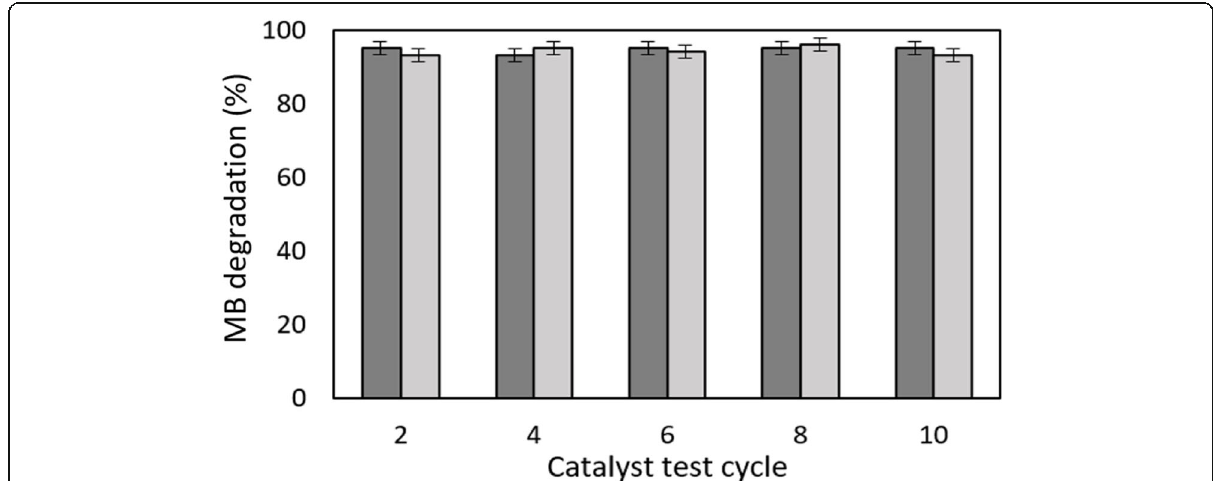
Fig. 10 MB degradation reached after 150 min of reaction under optimal conditions using Nb 2 O 5 /Al 2 O 3 /Al catalyst. Ref: MB solution (distilled water), Model textile